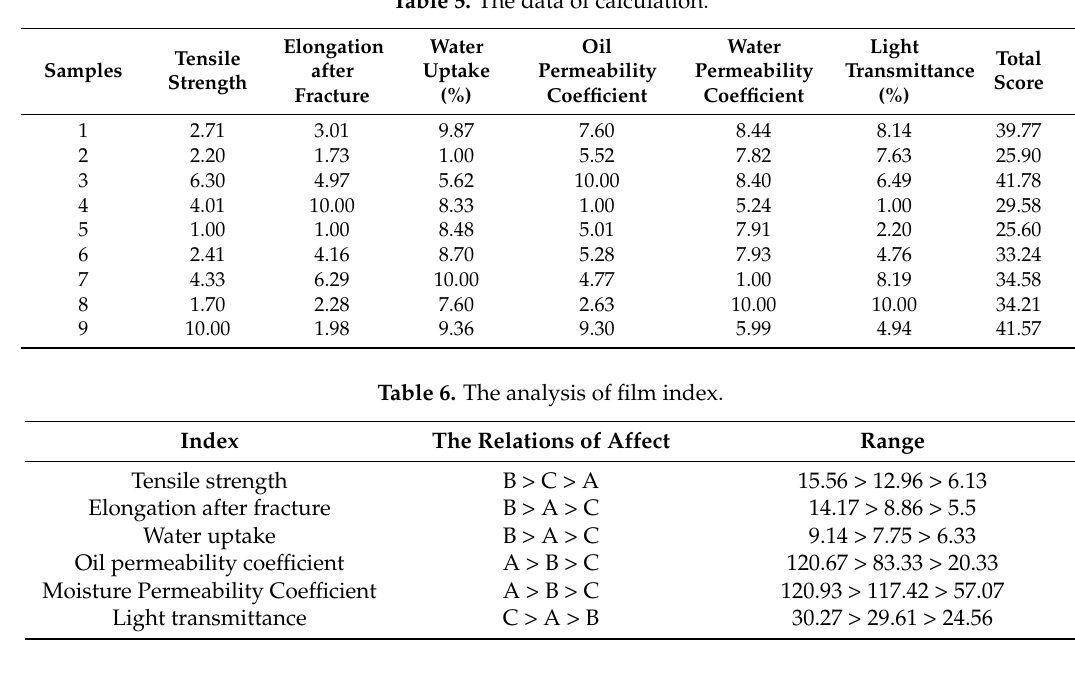
Table 5. The data of calculation.